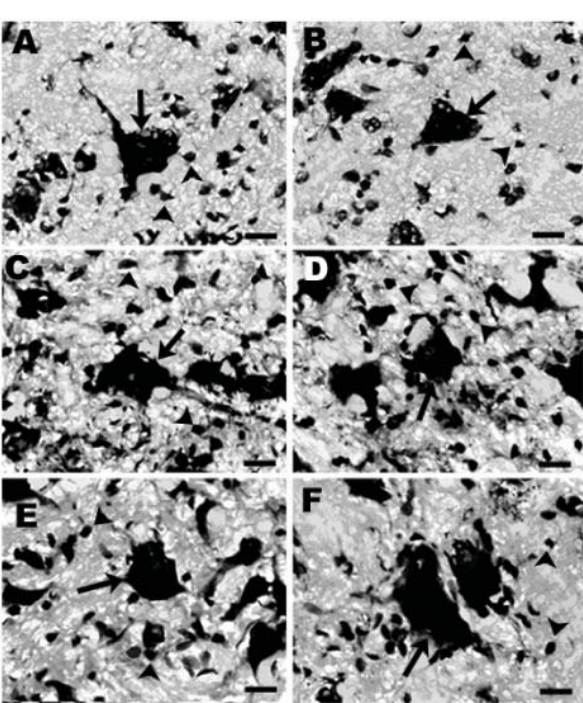
FIGURE 5 - Microphotographs showing cresyl violet staining, a marker for Nissl substance in neurons (arrows) and putative glial cells (arrowheads), in the ventral horn of the rat spinal cord at the lumbar level. Rats were submitted to a unilateral contiguous double crush of the sciatic nerve and treated with local injection of phosphate buffered saline (PBS; A,B), a cultured Schwann cell suspension (C,D) or a injured spinal cord extract (E,F). Anterior horn ipsilateral (A,C,E) and contralateral (B,D,F) to the axotomy are shown. Bars: 20 μ